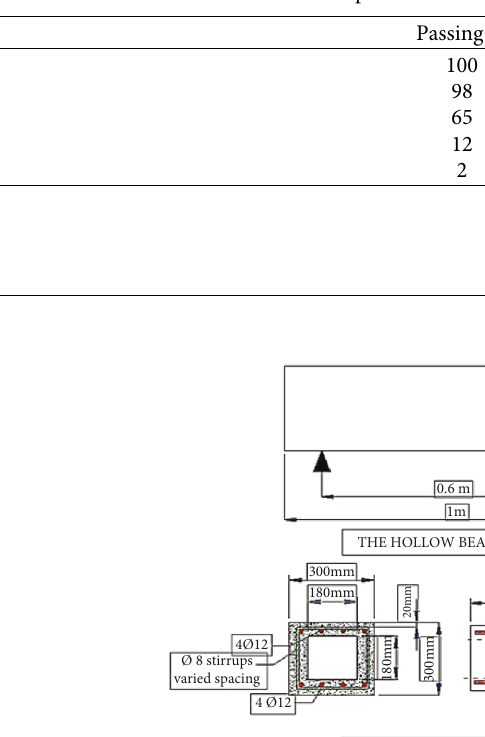
Table 4: Specification of used gravel [18].